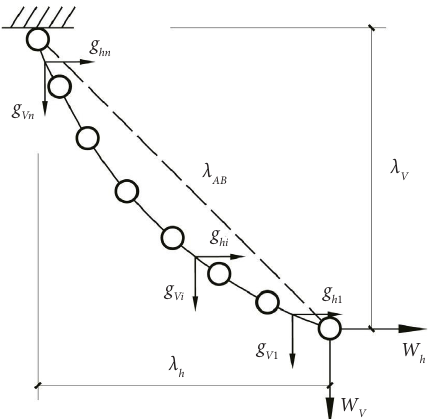
Figure 4: Te mechanical analysis of the compression limb.